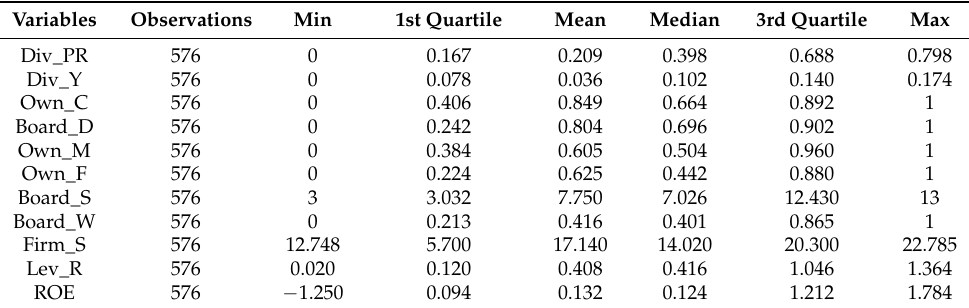
Table 2. Descriptive statistics for the